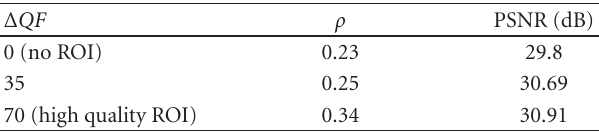
Table 3: Overhead and average PSNR using MJPEG on the Crowd Run